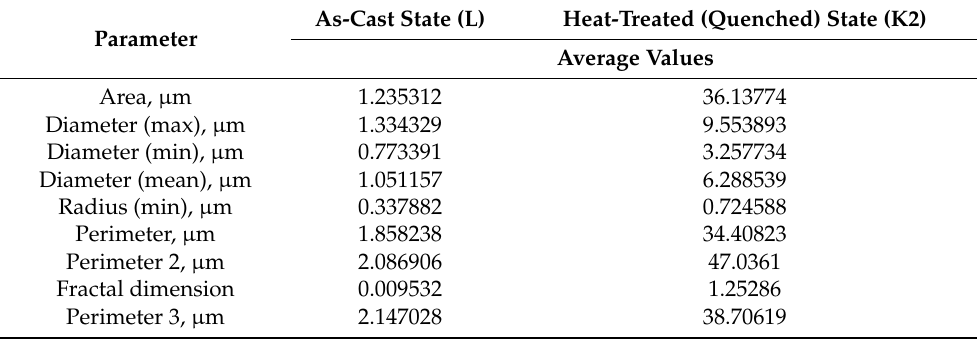
Figure 6. SEM of the sample after quenching and 420 min of cavitation exposure (K2) (the scale bar: 100 µ m). Table 1. Analysis of morphological parameters for the samples after exposure to cavitation testing (420 min).